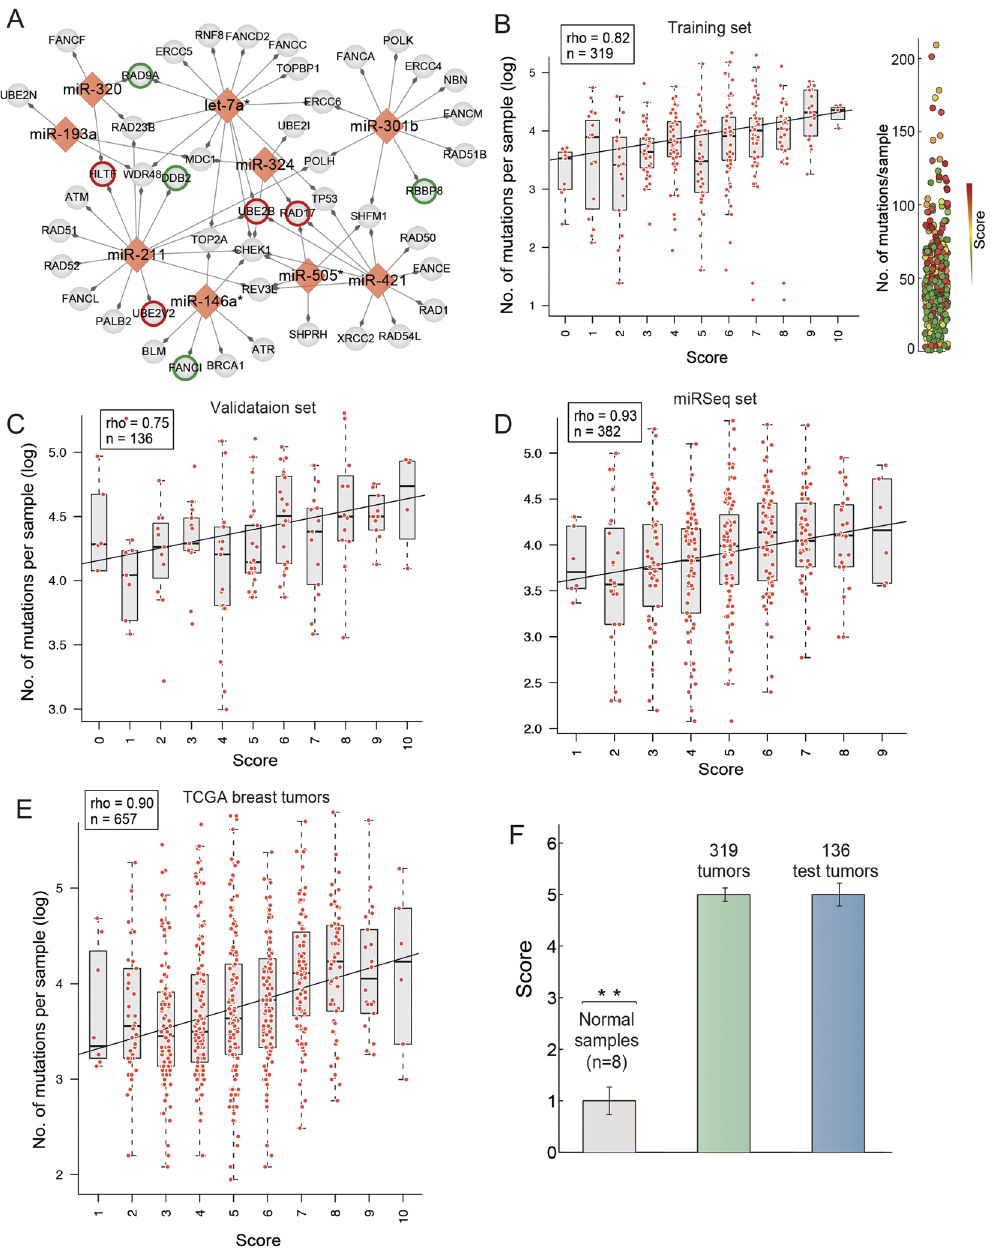
Figure 2. The 10-miRNA-score predicts genome instability in ovarian cancer. ( A ) The predicted targets of the ten miRNAs correlated with genome instability are enriched in the DDR genes responsive to platinum. miRNA miR-151 and miR-502 are not shown here because no platinum-responsive DDR genes were found. The coloured border indicates the prognostic genes of ovarian cancer (green for favourable outcome and red for poor outcome) ( B ). The correlation between the 10-miRNA-score an level of DNA damage in the training set of ovarian cancer. Shown on the right panel is a visual illustration of the distribution for tumours with different numbers of mutations and 10-miRNA-scores. ( C ) Validation of the correlation between the 10-miRNA-score and DNA damage level in an independent dataset of ovarian cancers. ( D ) Validation of the correlation between the 10-miRNA-score and DNA damage level using miRNA-Seq data. ( E ) The 10-miRNA-score also shows a significant correlation with genome instability in breast cancer. ( F ) The 10-miRNA-score of normal controls was significantly lower than that of tumour samples of ovarian cancer (p < 0.01 compared with tumours in the training set and the test